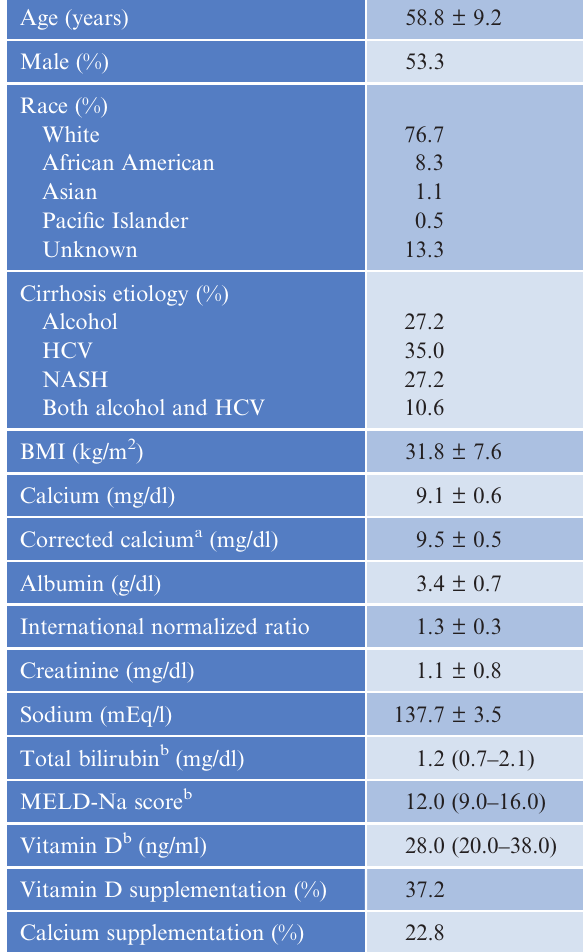
it is possible that low 25(OH)D levels simply re fl ect liver dis- Table 1. Demographics of the patient participants (N = 180)